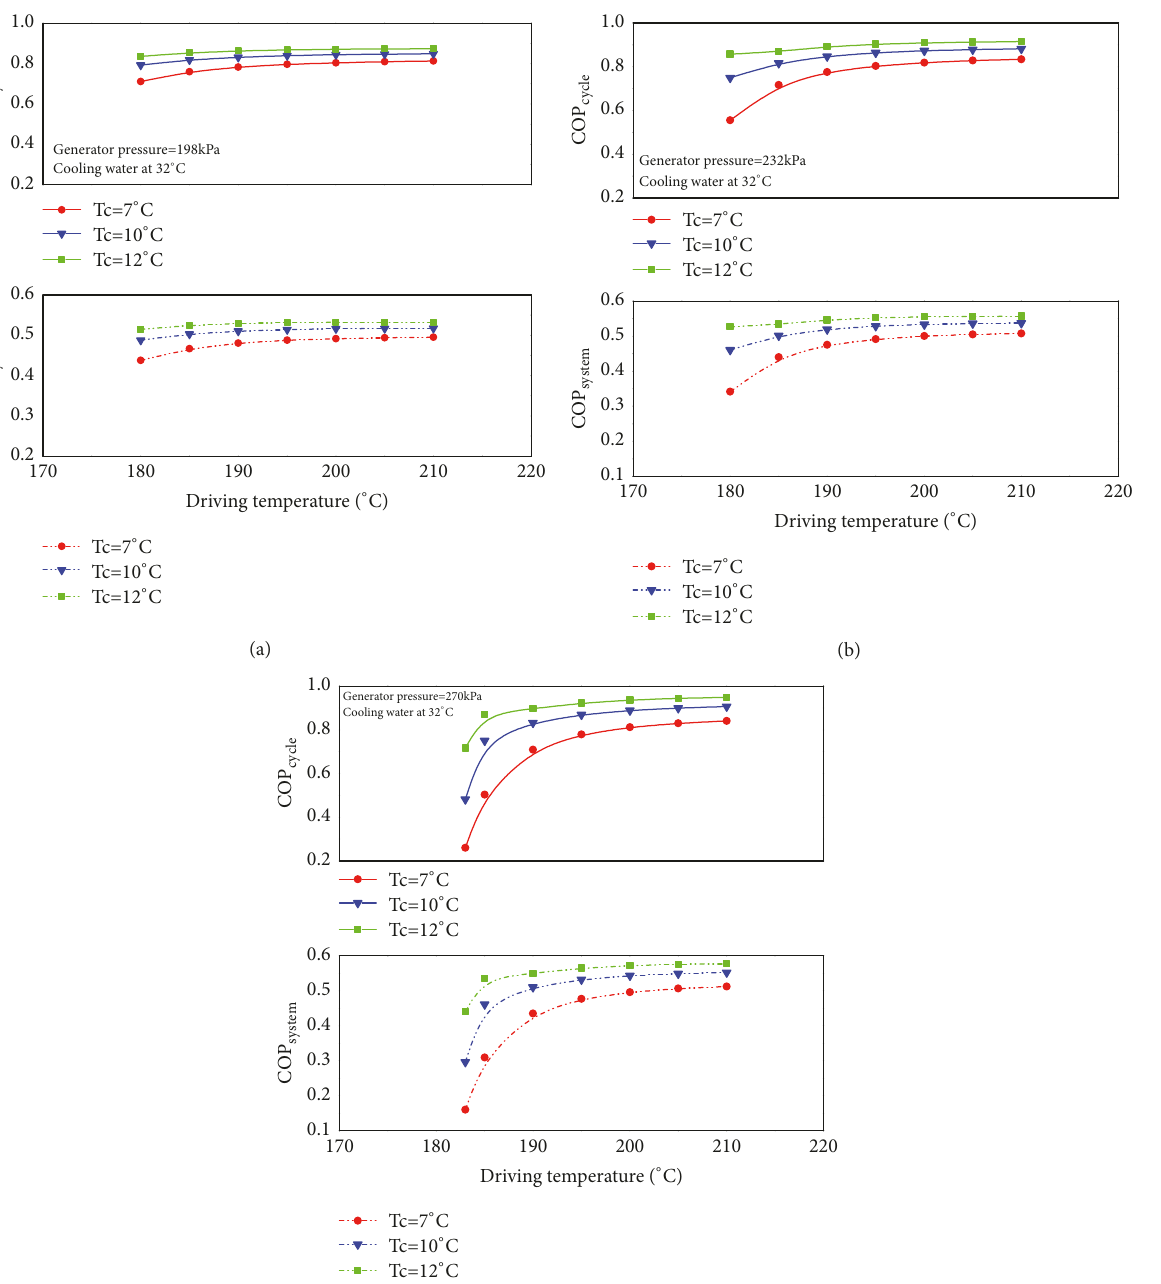
combined single-effect absorption refrigeration system